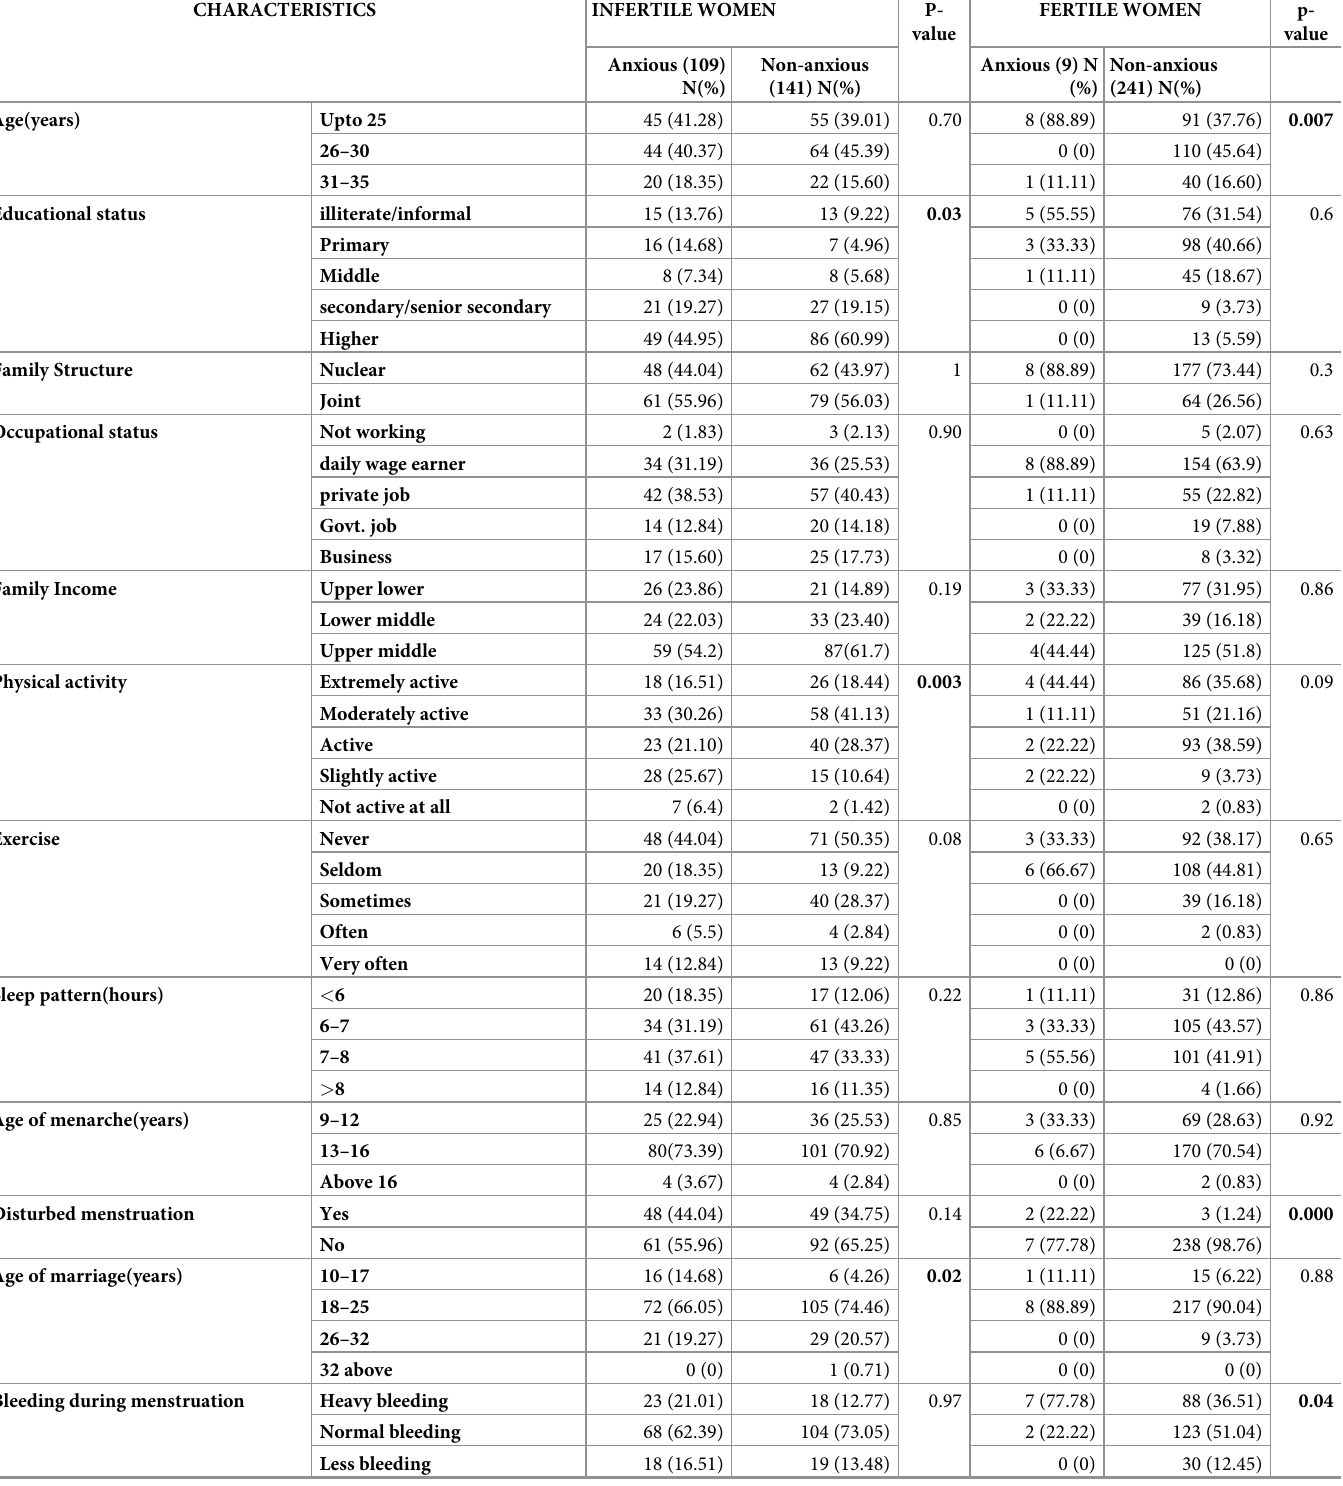
Table 4. Distribution of demographic, lifestyle variables and reproductive trajectories in infertile and fertile women in the anxiety category.